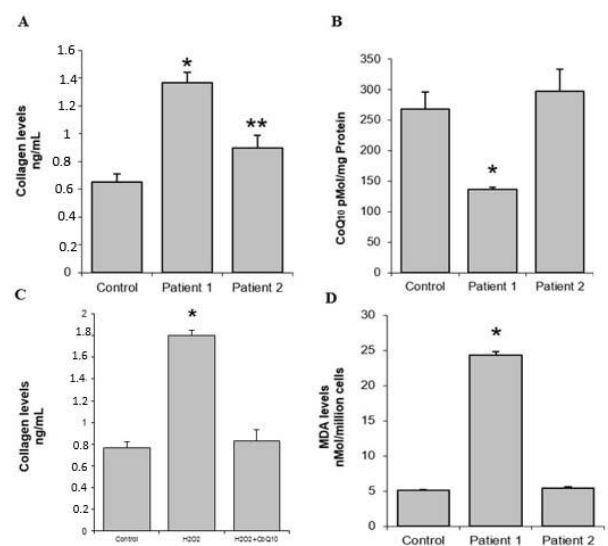
Figure 4. Biochemical determinations. ( A ) Collagen levels in gingival tissue; higher values were observed in patient 1. ( B ) The CoQ 10 level was significantly decreased in the patient 1. ( C ) Collagen synthesis in patient 1 was significantly increased with oxidative stress; these levels were restored with the addition of the antioxidant CoQ 10 . ( D ) Lipid peroxidation in patient 1 was significantly increased. * = p < 0.01, ** = p < 0.05.